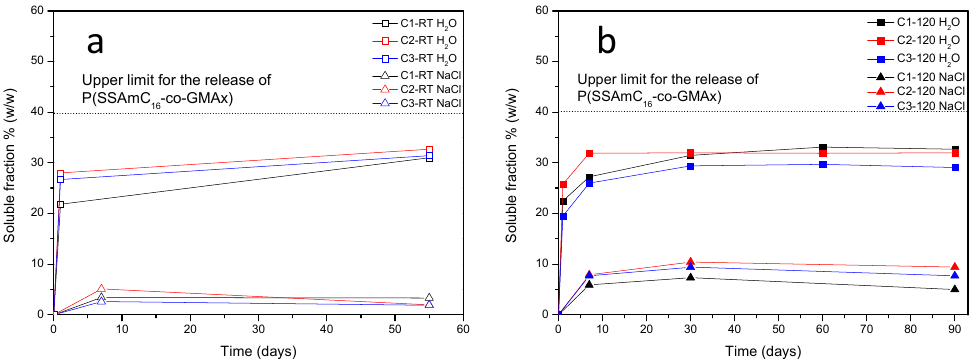
Figure 3. Evolution of the soluble fraction % ( w / w ) after immersion in ultra ‐ pure water and aqueous NaCl 1 M solution for different time periods. ( a ) Uncured C1 ‐ RT, C2 ‐ RT, C3 ‐ RT polymeric coatings, ( b ) Cured C1 ‐ 120, C2 ‐ 120, C3 ‐ 120 polymeric coatings.